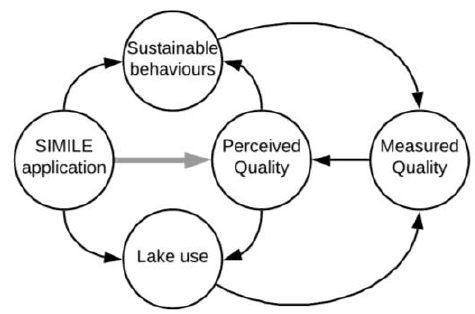
Figure 1. Scheme on how SIMILE application interacts with